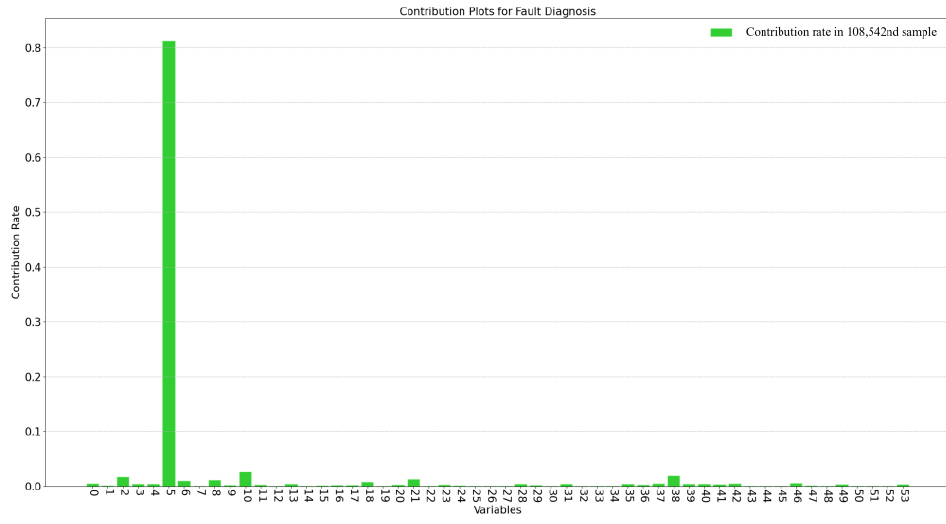
Figure 18. Contribution plots calculated in the 108,542nd sample.